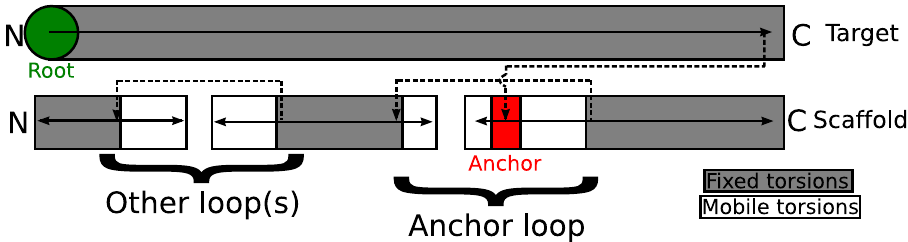
Figure 4. Fold tree diagram. This figure, modeled after the fold tree diagrams in Figure 1 of Wang et al. [26], demonstrates the kinematic connectivity that makes AnchoredDesign work. The arrows trace the direction of folding as Rosetta recalculates 3D coordinates from internal coordinates, starting at the green root residue. The upper and lower sections represent the target and scaffold respectively. Shaded regions represent rigid torsions (including the entire target and the core of the scaffold, in this case). Unshaded regions represent mobile torsions: the loops. All jumps between noncontiguous residues (dotted lines) are held rigid. AnchoredDesign embeds rigid torsions (the anchor, red) inside a loop, and affixes the anchor to the target by having the anchor’s coordinates depend on the target instead of the scaffold in which the anchor is embedded. The scaffold is then dependent on the anchor via the mobile loop containing the anchor. Also allowed are arbitrarily placed other loops, handled with the standard loop fold tree.